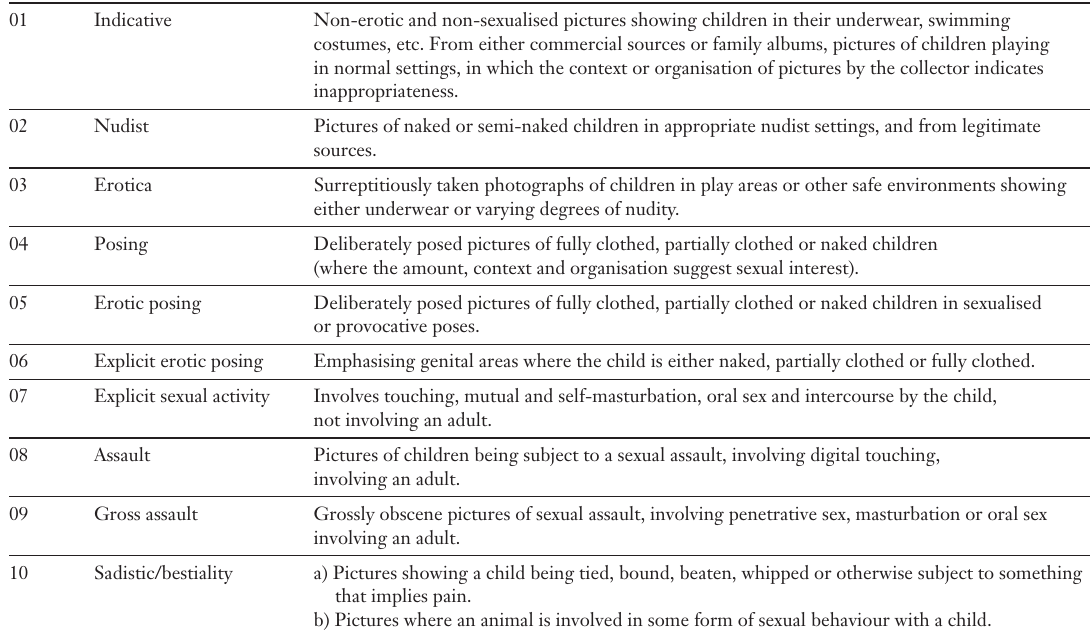
Qualitative taxonomy of different kinds of child-pornography according to Taylor & Quayle